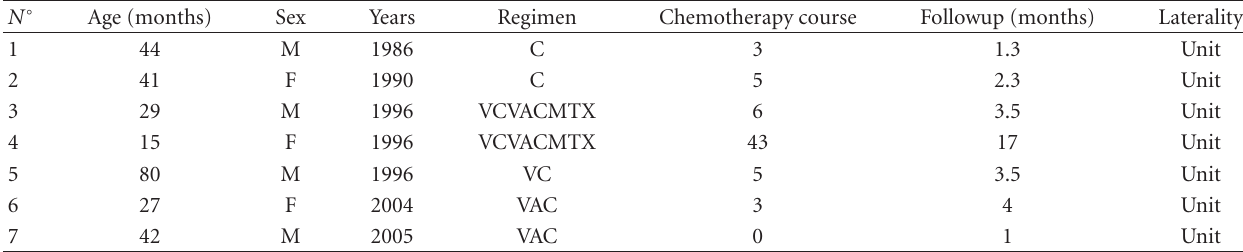
Table 4: Characteristics of 7 patients who died of